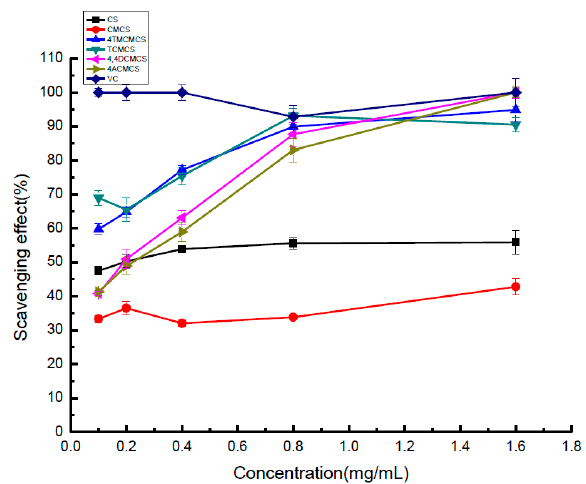
Figure 6. Superoxide radicals’ scavenging ability of CS, N, O-CMCS , and Carboxymethyl chitosan containing thiourea salts.